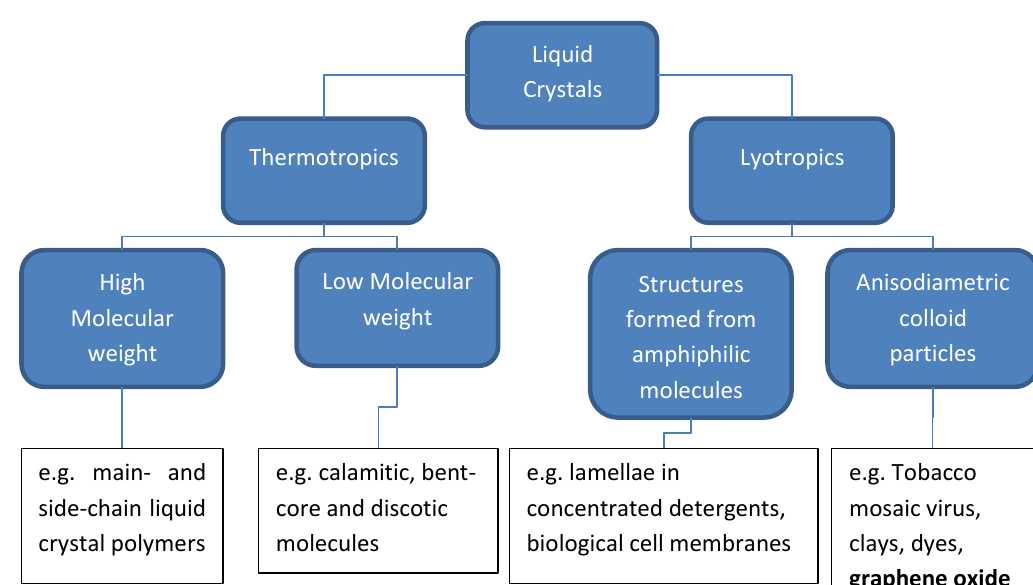
Figure 3. Flow diagram showing the nomenclature used in the field of liquid crystals. Examples are given of each type of liquid crystal (LC).